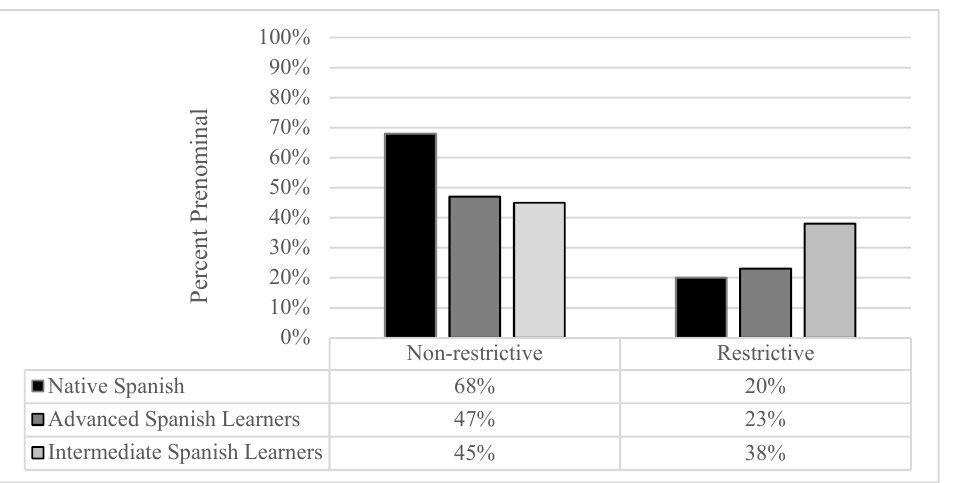
Figure 3. SCT group results.